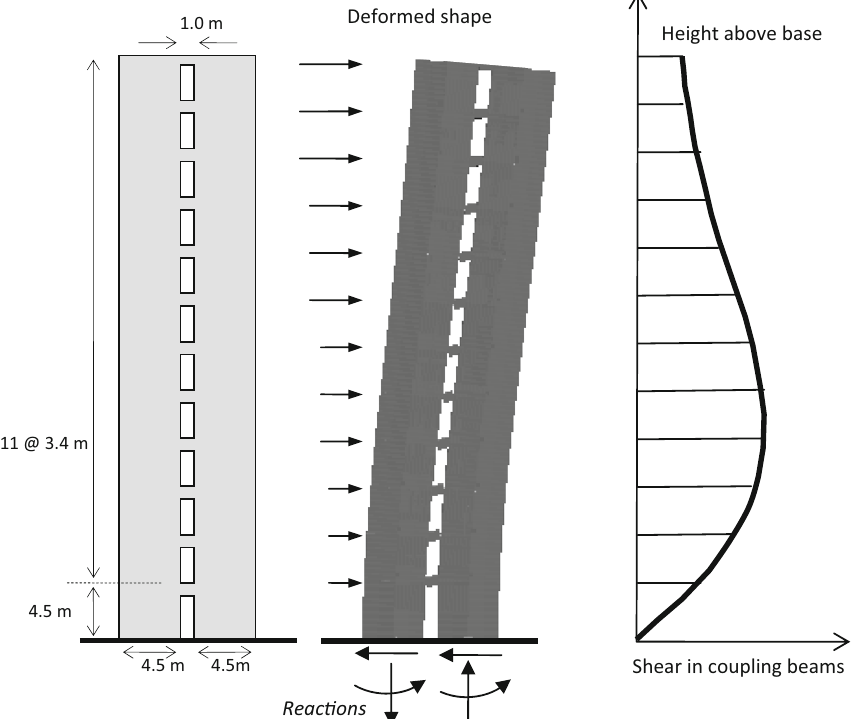
Fig. 2 Deformed shape (exaggerated) and coupling beam shear distribution during the linear elastic response of a 12-story coupled wall.